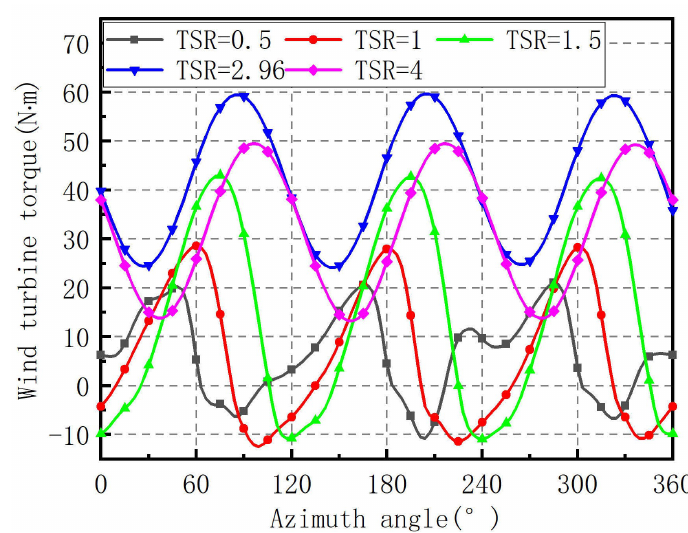
Figure 21. Curve of torque changing with azimuth.